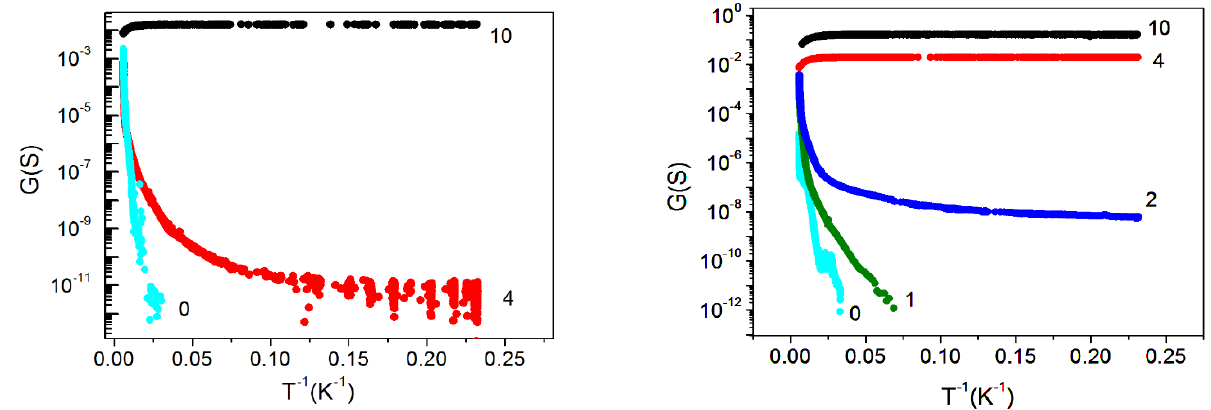
Figure 6. Temperature dependence of conductivity G for structures with different thicknesses of epitaxial films. Left panel:29 nm thick film; right panel:53 nm thick film. The numbers next to the experimental curves correspond to the electron exposure time measured in minutes.